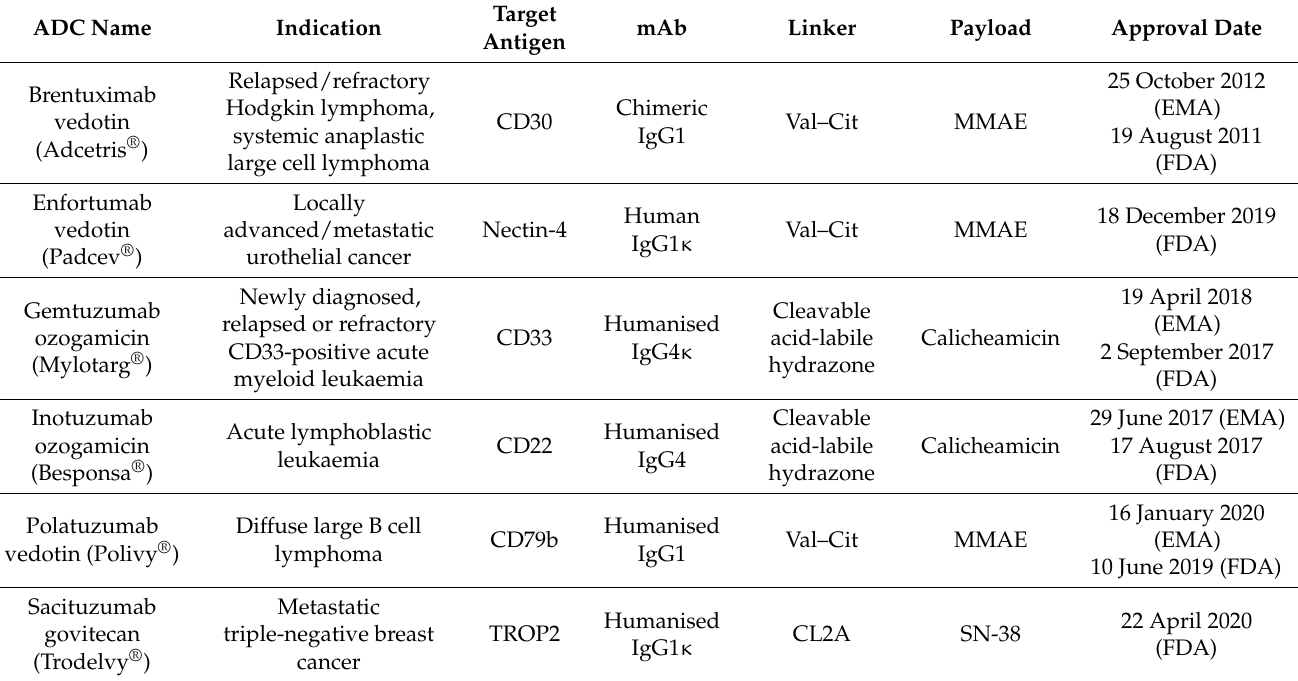
Table 2. ADCs currently approved for clinical use in the European Union and the